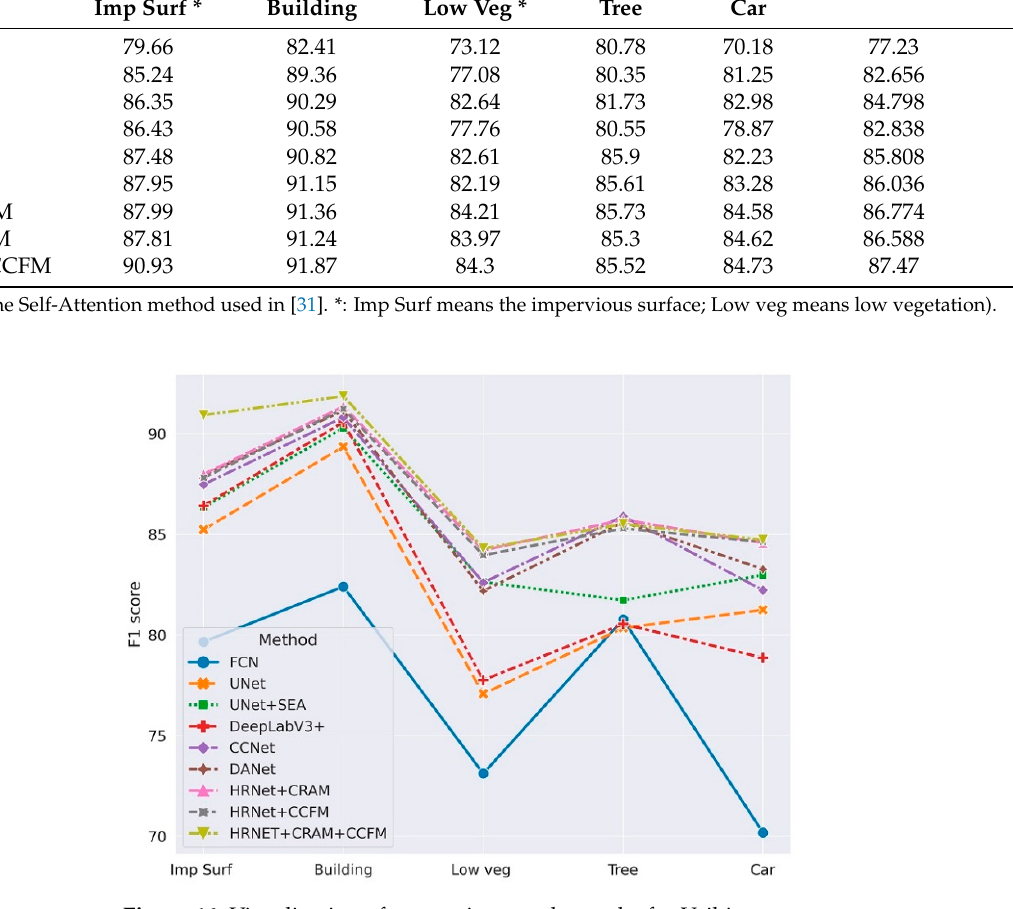
Figure 16. Visualization of comparison study results for Vaihingen.